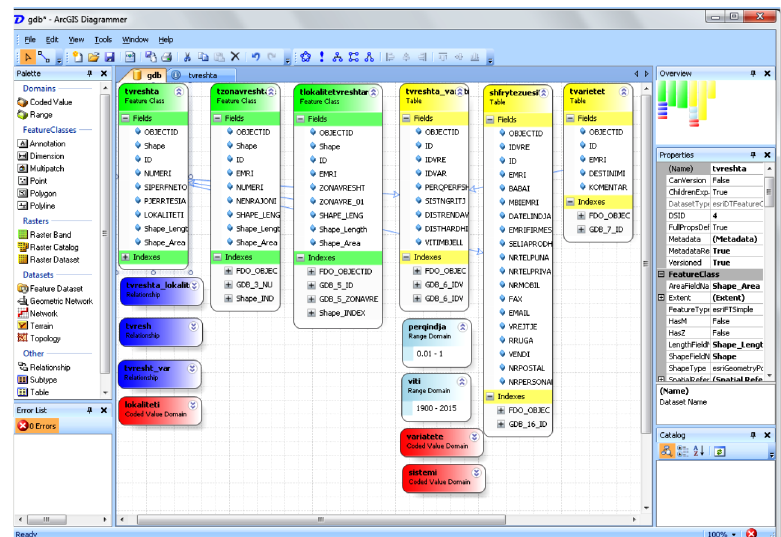
Figure 2. Geodatabase design – ArcGIS diagrammer